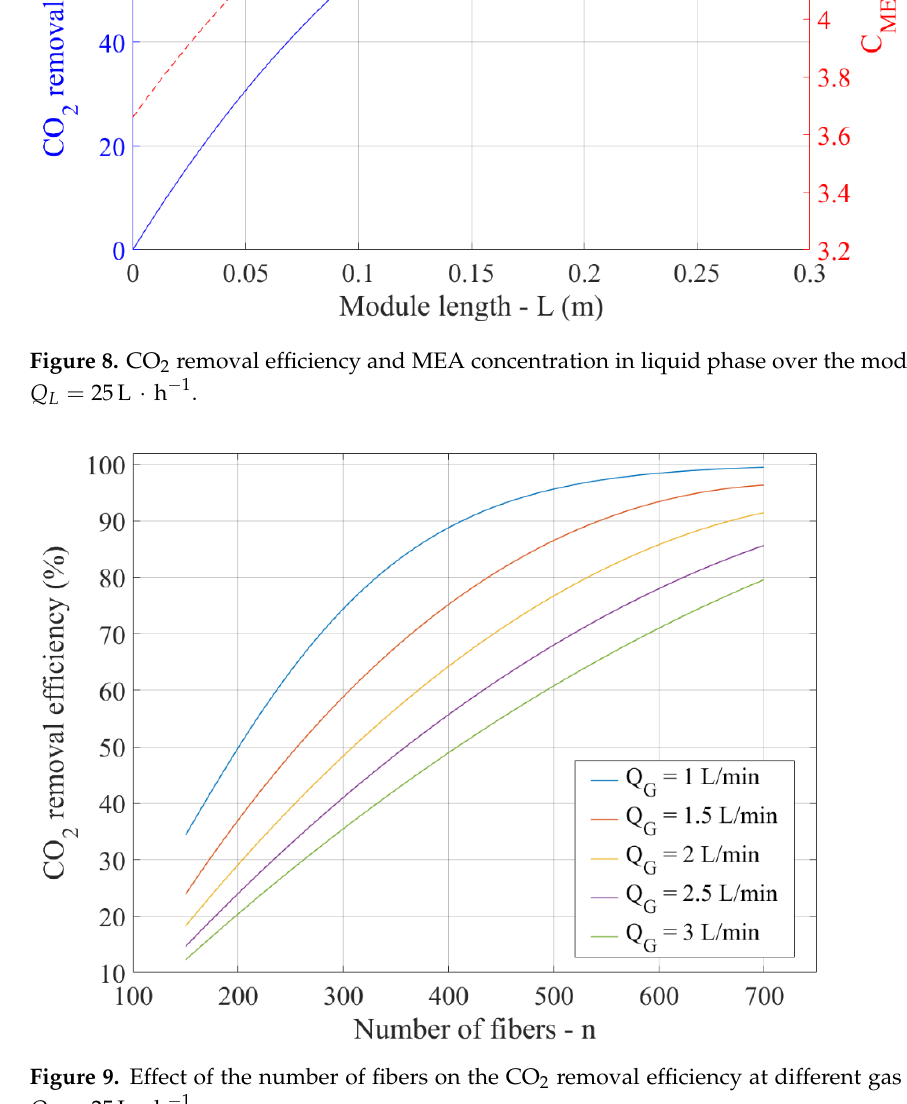
Figure 10. Effect of the number of fibers on the CO 2 removal efficiency at different liquid flow rates, 1 2